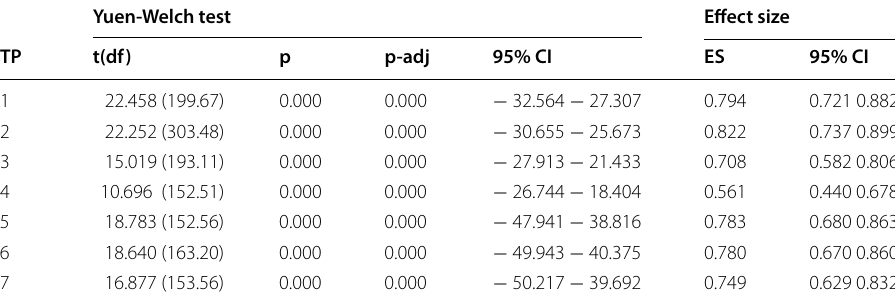
Table 5 Comparison of experimental conditions (control, non-gamified; and experimental; gamified) in terms of participants’ system access for each time-point (TP) Yuen-Welch